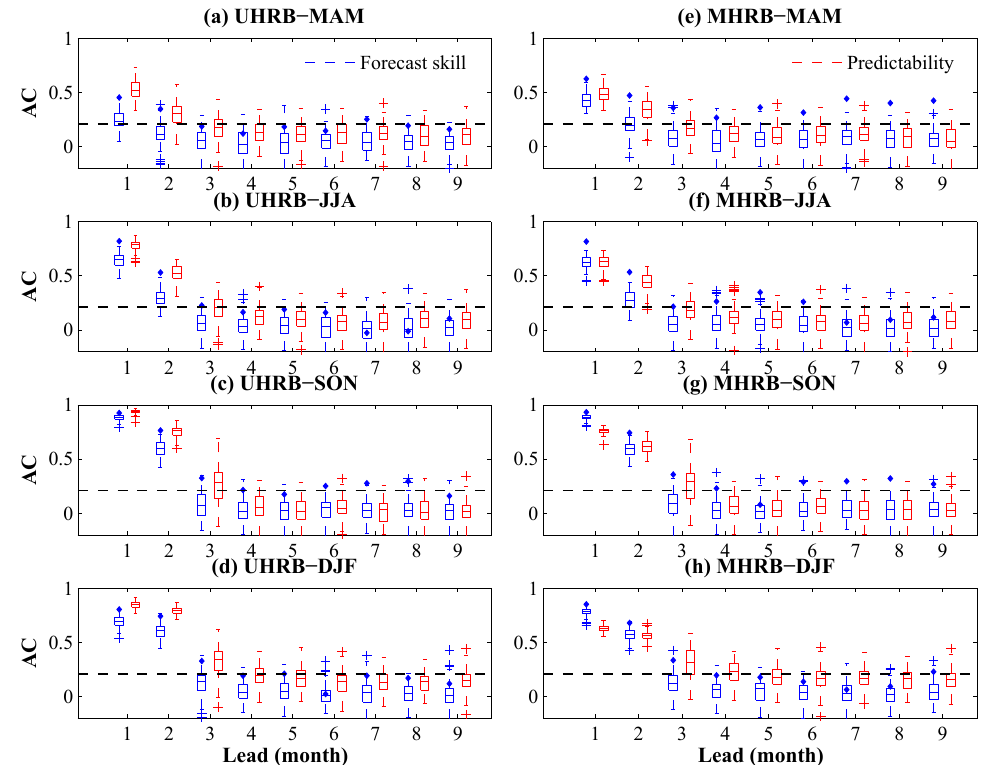
Figure 3. Anomaly correlation (AC) of the forecast of seasonal SPI3. The red box plots show the spread of predictability, and the blue box plots show the spread of forecast skill for each ensemble member. The blue diamonds show the AC of the grand ensemble mean. The blue (red) crosses show the outliers for forecast skill (predictability). The dashed black line indicates the threshold (AC = 0.21) of 95% confidence intervals calculated from the t